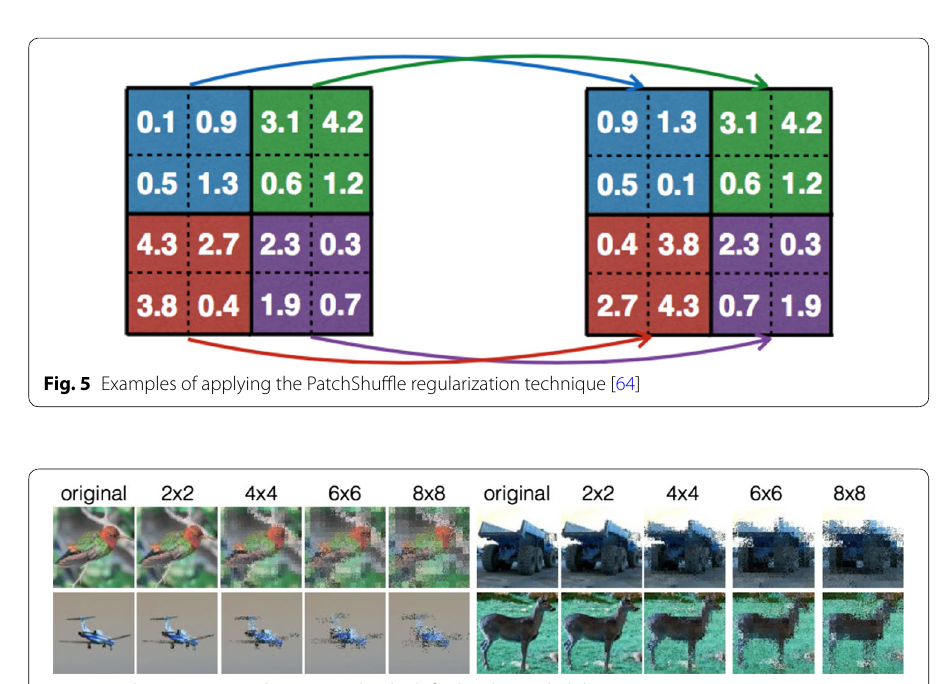
Fig. 6 Pixels in a n n window are randomly shifted with a probability parameter ×